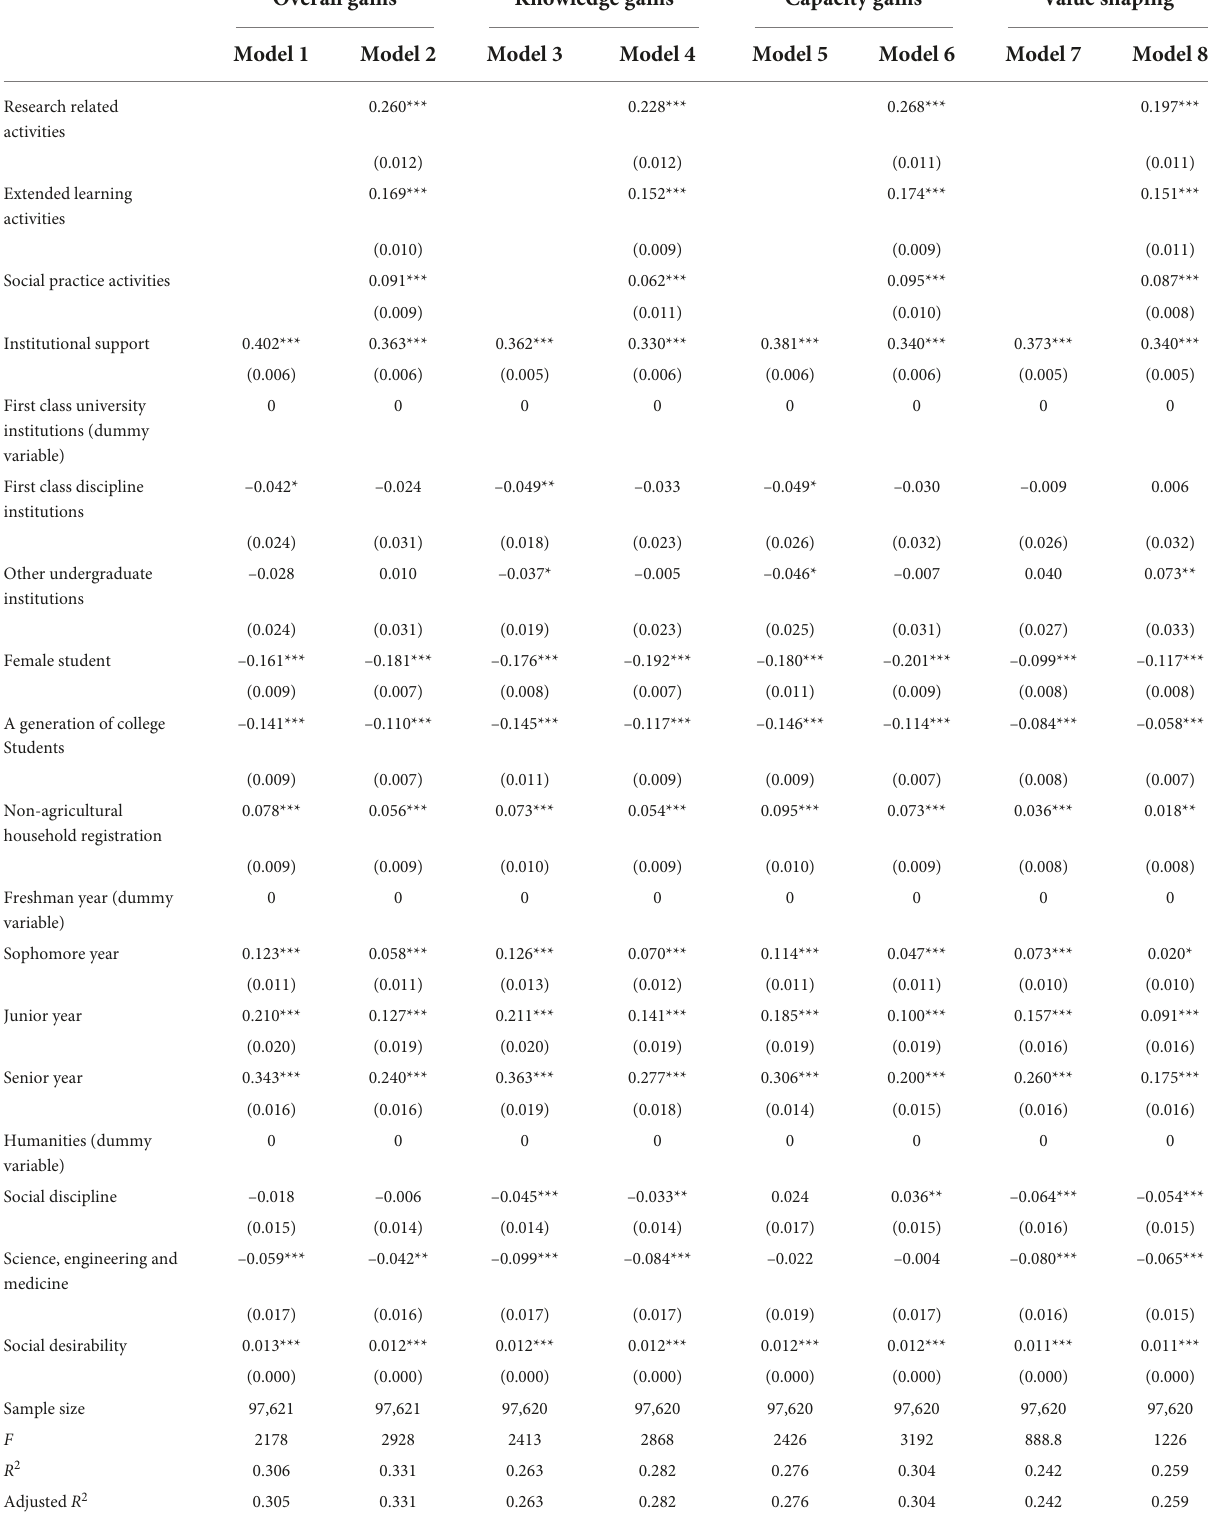
TABLE 5 Regression analysis of HIPs on students’ learning